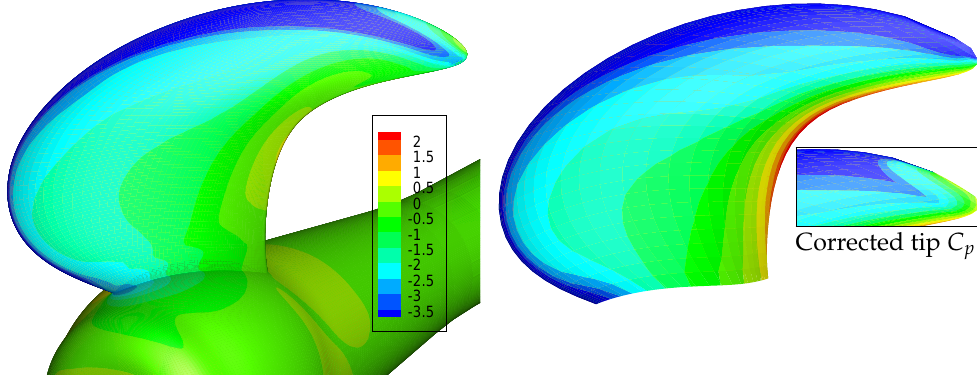
Figure 7. Pressure coefficient, C p , on the suction side for J = 0.37, RANS ( left ) BEM ( right ). The insert figure shows the BEM pressure distribution after the tip pressure correction.